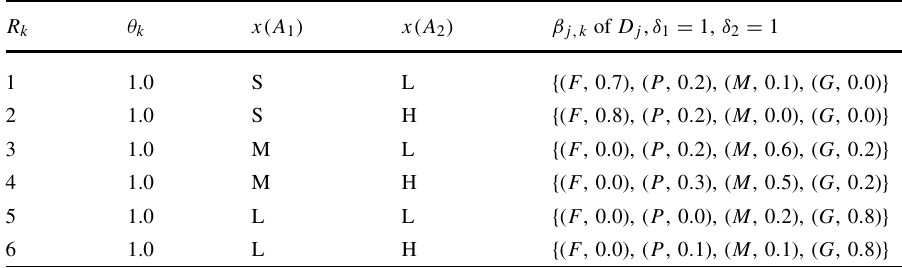
Table 2 Initial parameters of the BRB